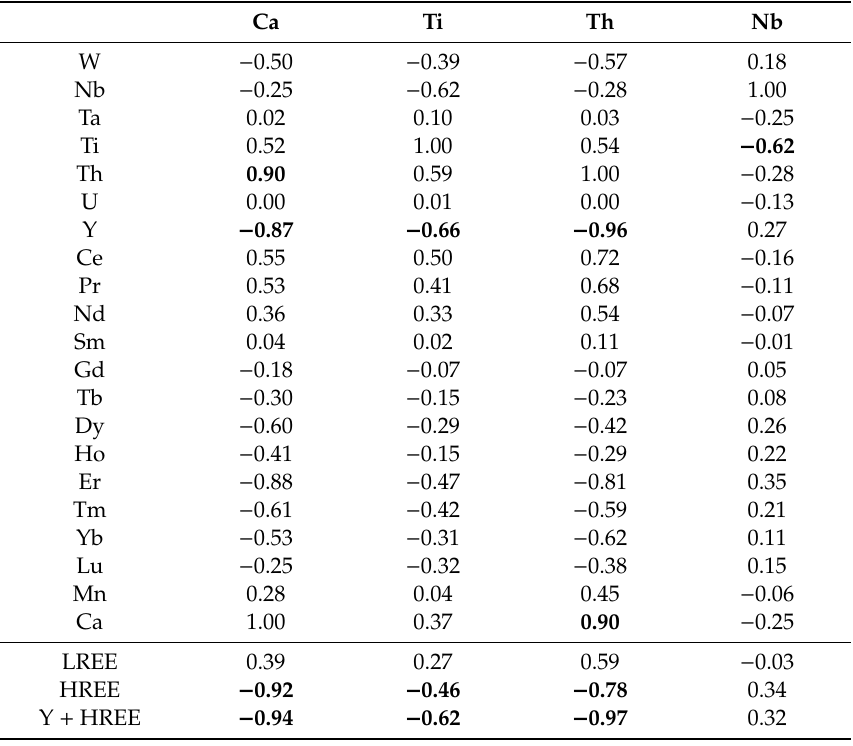
Table 2. Correlation coe ffi cients ( r 2 ) for major elements in